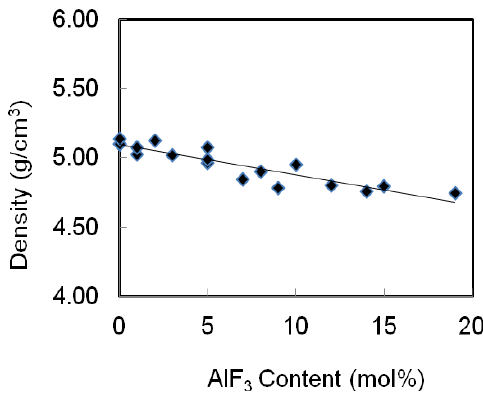
-ZnO-TeO glasses. The line is drawn to guide the eye. 3 2